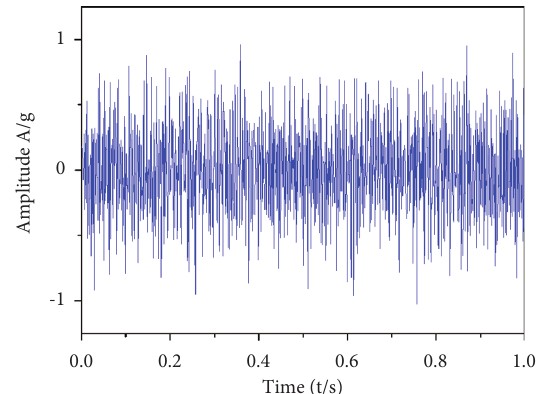
Figure 5: The time-domain waveform with 10dB noise of the analog signal.